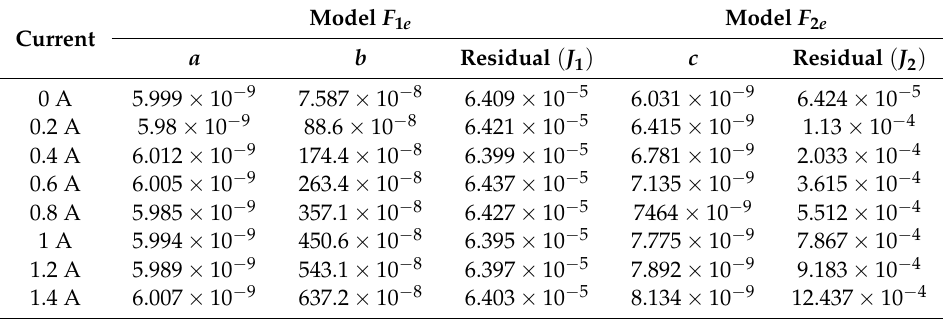
Table 3. Parameter estimation of the model F 1 e and F 2 e , by current characteristics 0 A–1.4 A.